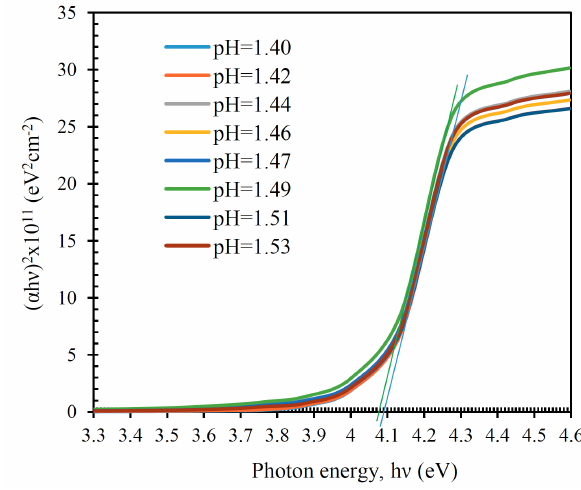
Figure 12. The ( α h ν ) 2 versus h ν . Table 1. Optical bandgap and Burstein–Moss shift.